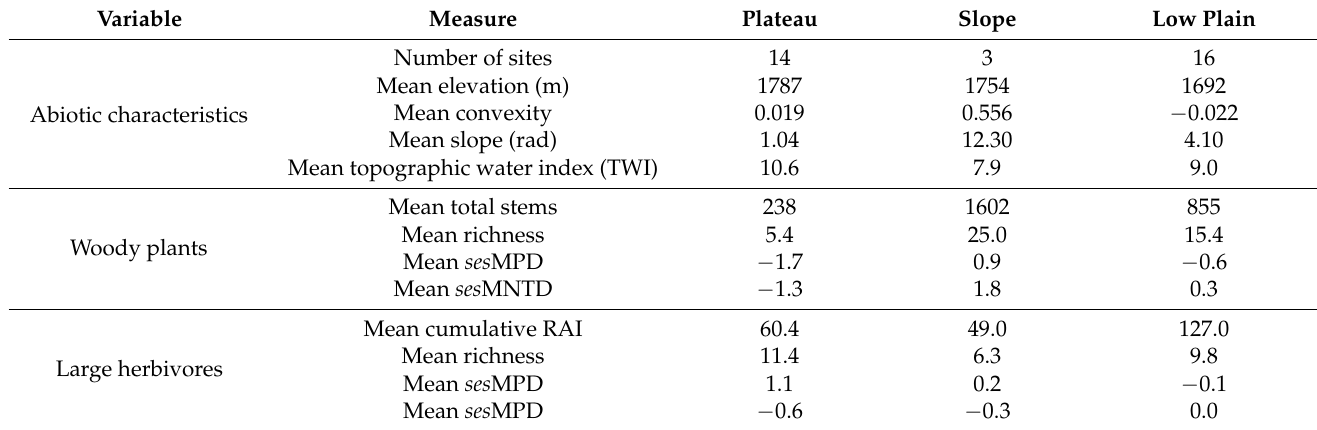
Table 1. Summary of ecological characteristics at 33 grid sites across three